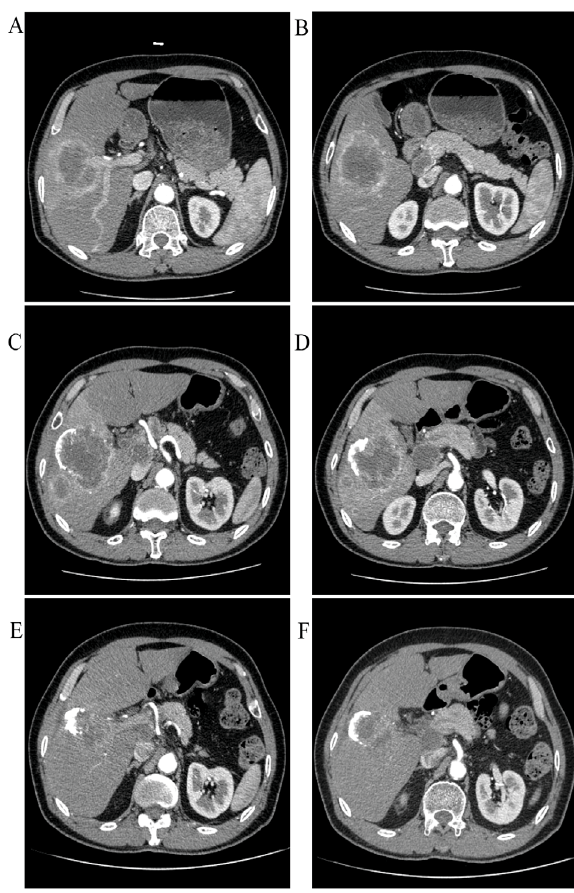
Figure 2: Abdominal computed tomography (CT) imaging of meta- static live lesion lymph node lesions before and after AZD9291 treatment. (A and B) At diagnosis of the metastases after admi- nistrating icotinib for 14 months (Dec 23, 2014); (C and D)After 2 months of transcatheter arterial chemoembolization, revealing disease progression (Mar 27, 2015); (E and F)After 20 days of com- bination treatment of icotinib and AZD9291, revealing a dramatic response(Apr 3,